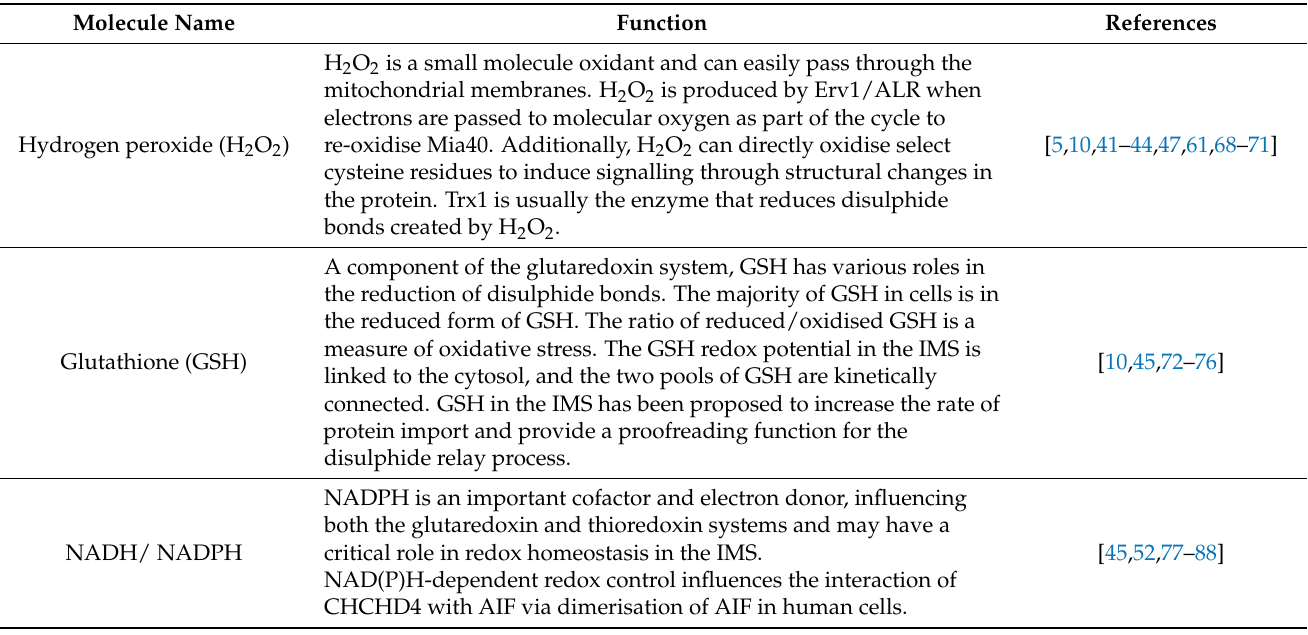
Table 2. Small redox-active molecules associated with redox regulation in the mitochondrial IMS discussed in this review. Molecule Name